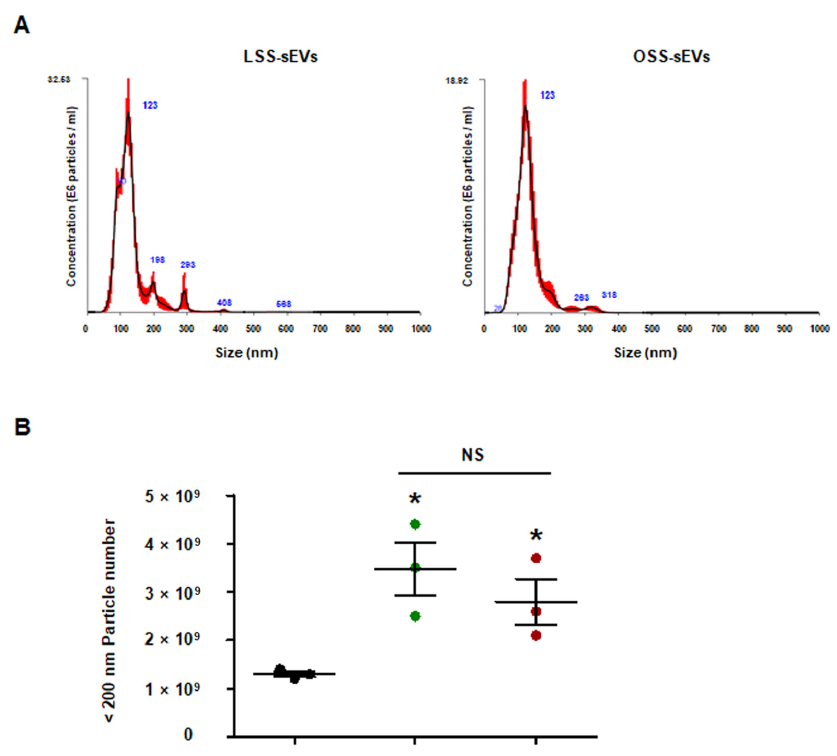
Figure A4. Quantity of iMAECs-sEVs under FSS conditions. The iMAECs were cultured under static or FSS conditions for 24 h. Static EC-sEVs (Static-sEVs) or shear stress-induced EC-sEVs (LSS- or OSS-sEVs) were isolated from culture media using ultrafiltration. Size ( A ) and quantity ( B ) of EC-sEVs were analyzed using NTA. ( n = 3; * p < 0.05 compared to static, NS = no significant). Mean ± SEM. Statistical analysis was performed using the nonparametric Mann–Whitney U test.